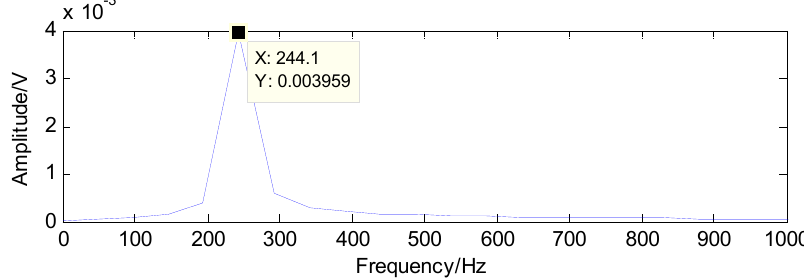
Figure 19. First detection result using the raw signals based on the method in [37]. Sensors 2016 , 16 , 1524